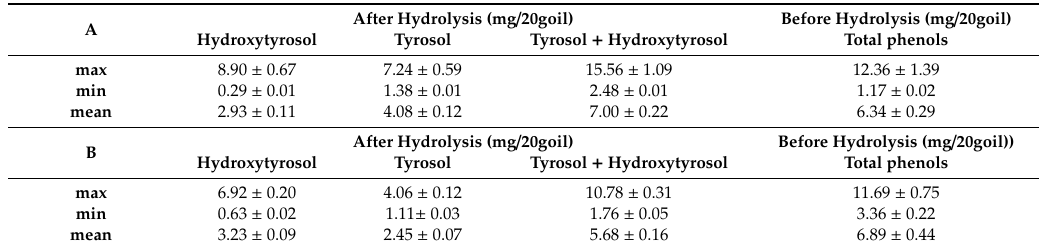
Table 4. Evaluation of the mean values before and after acidic hydrolysis was applied to 64 extra virgin olive oils produced in Tuscany and Apulian regions in 2017 ( A ) and in Tuscany in 2018 ( B ). After Hydrolysis (mg / A